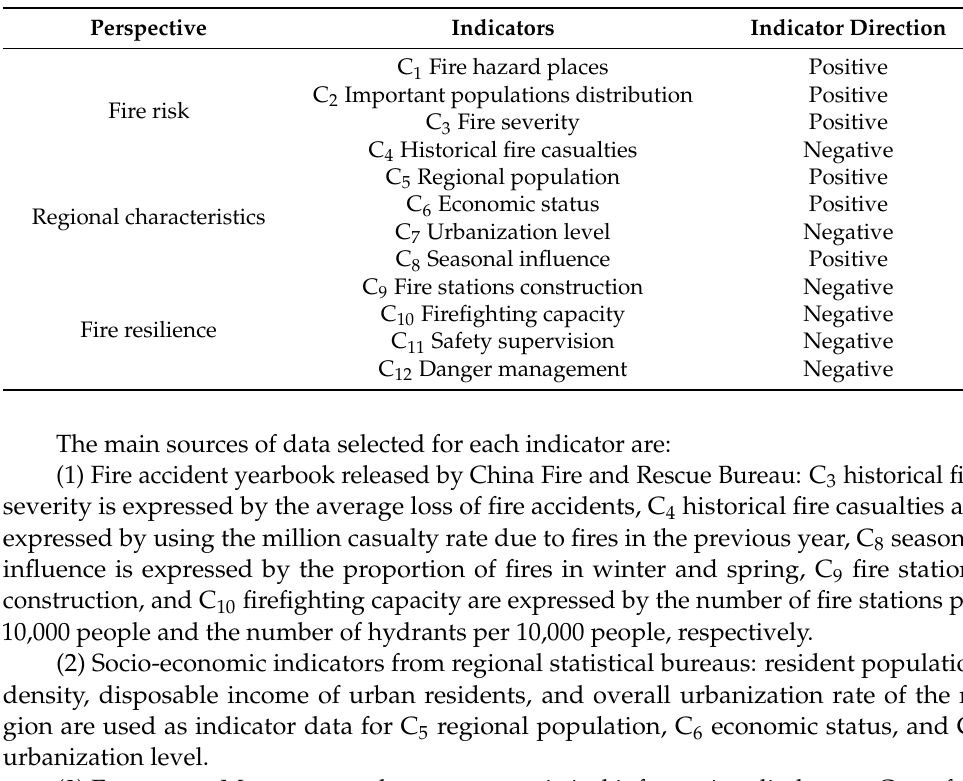
Table 1. Urban fire risk evaluation index